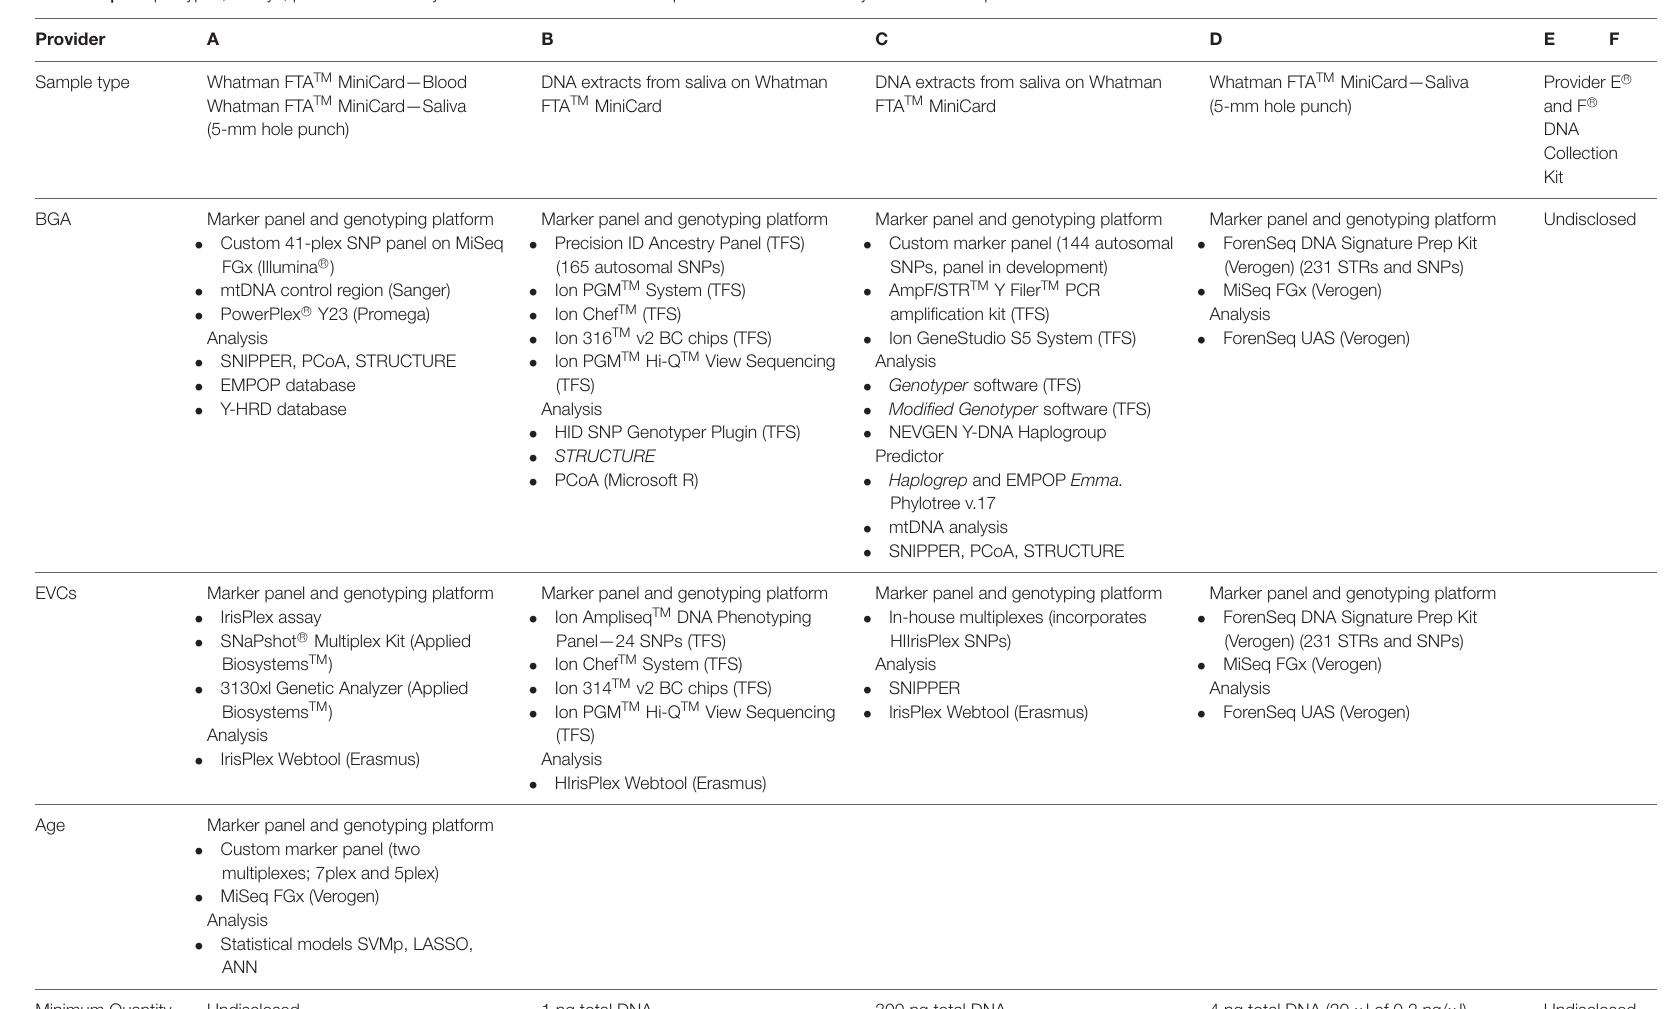
TABLE 2 | Sample types, assays, platforms and analysis methods for BGA and EVC prediction as disclosed by the six service providers. Provider A B C D E F Sample